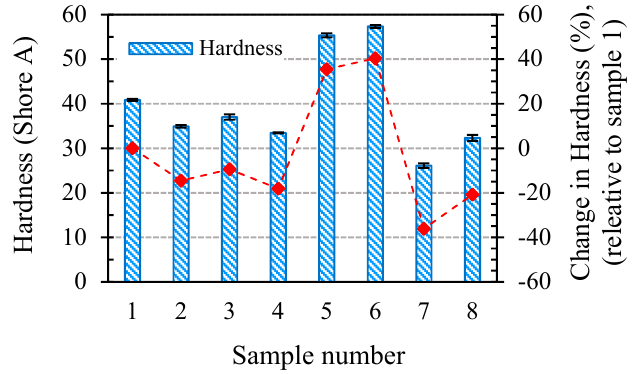
Figure 3. Effect of different ageing conditions on the hardness of the SR.